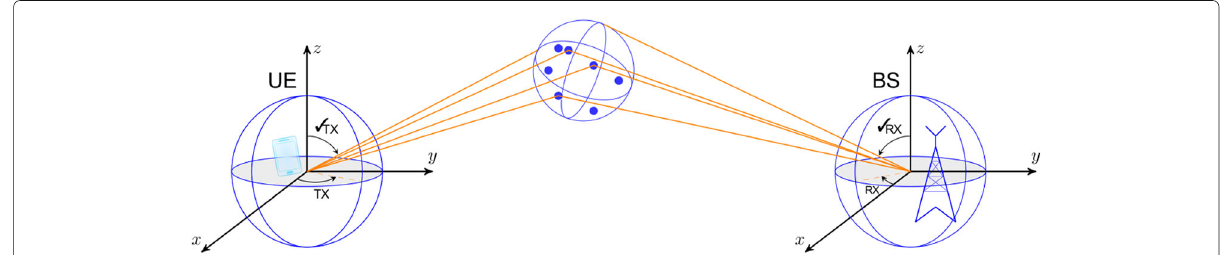
Fig. 2 Sketched representation of the channel model